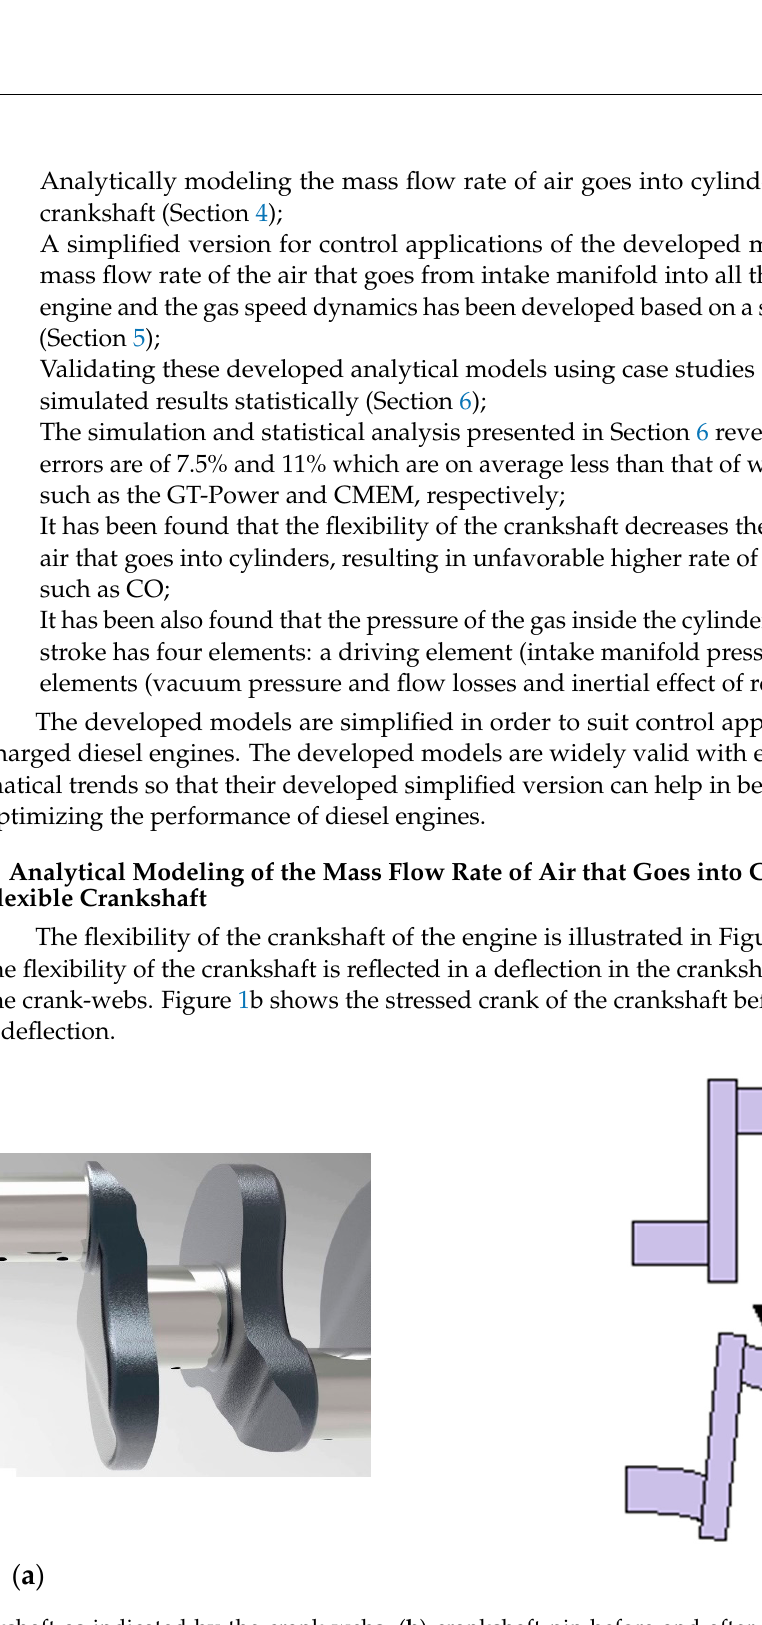
Figure 1. ( a ) Deflected crankshaft as indicated by the crank-webs, ( b ) crankshaft pin before and after deflection due to pressure.